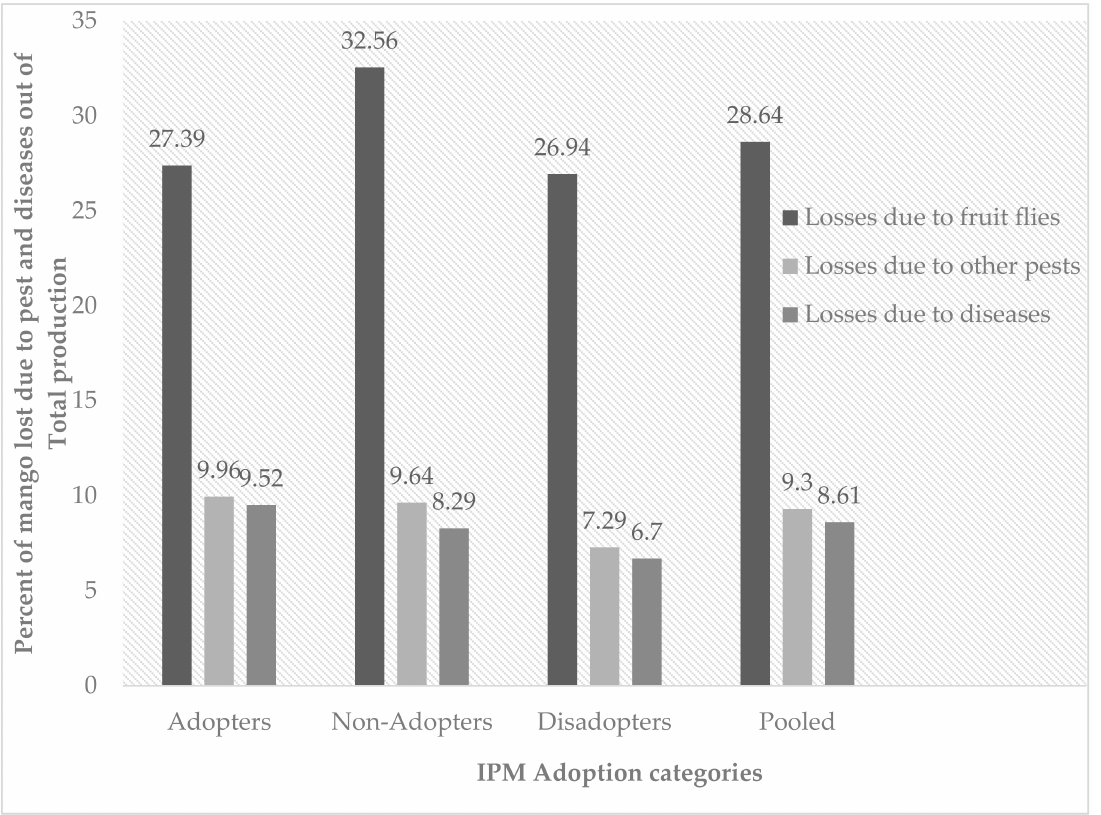
Figure 2. Perceived proportions of mango loss out of total production due to fruit flies and other mango-infesting pests and diseases in Embu